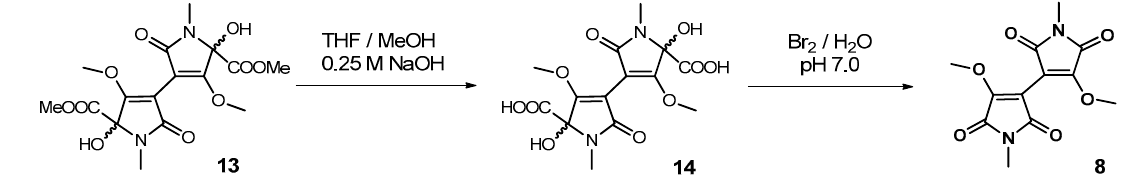
Figure 3. Synthesis of plicatanin B ( 8 ) by conversion of isochrysohermidin ( 13 ).